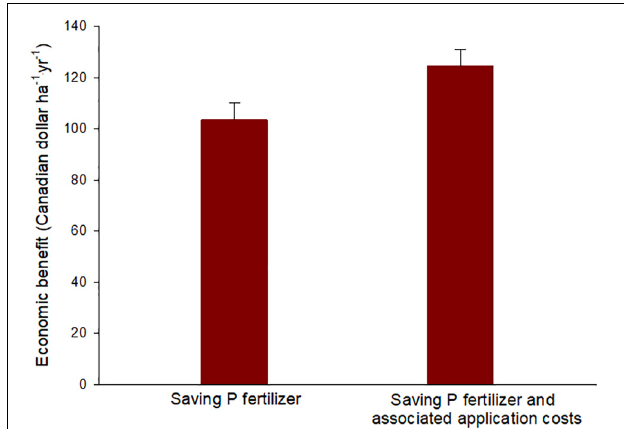
FIGURE 2 | Estimated annual economic benefit with continuous P draw-down under two scenarios: (1) economic benefit was gained by saving on P fertilizer only when the fertilizer was applied together with planting, and (2) economic benefit was gained by saving on both P fertilizer and associated fertilizer application costs when the fertilizer application and planting were separately performed. The vertical T-bars are standard errors ( n = 6).